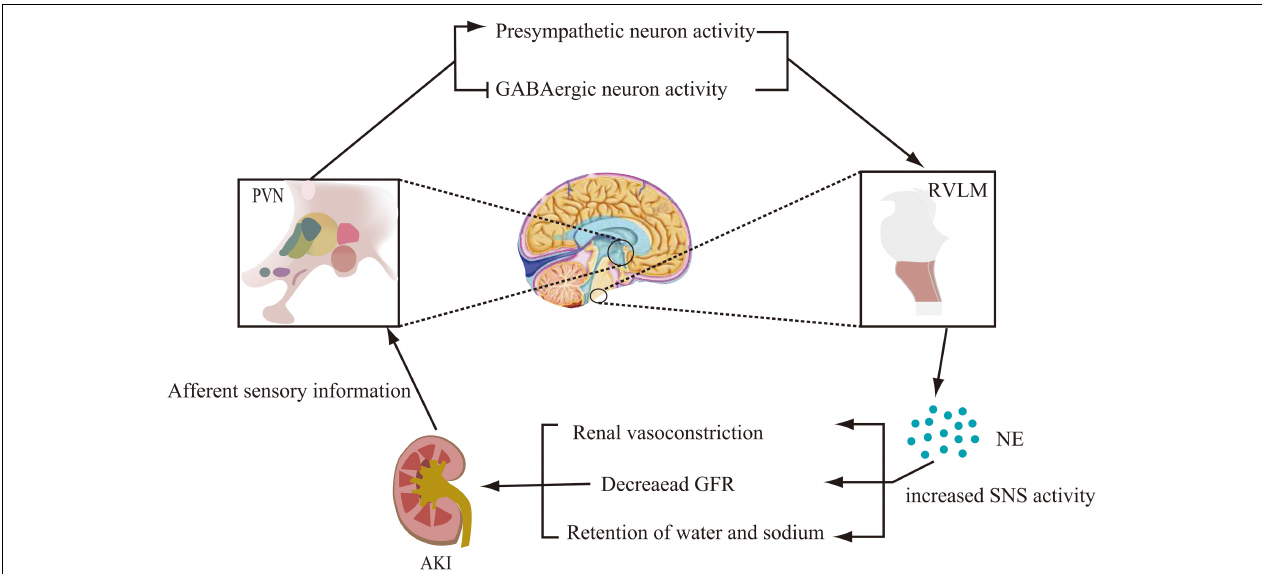
FIGURE 1 | Modification of the central nervous system pathways involved in sympathetic activation during acute kidney injury (AKI). Activation of renal afferent sensory nerves, which project to the paraventricular nucleus (PVN) of the hypothalamus, promotes pre-sympathetic neuronal activity and inhibits GABAergic neuronal activity. By projecting from the PVN to norepinephrinergic neurons in the rostral ventrolateral medulla (RVLM), norepinephrine (NE) levels are increased, thereby promoting sympathetic nervous system (SNS) activity, which further leads to renal vasoconstriction, decreased glomerular filtration rate (GFR), and sodium and water